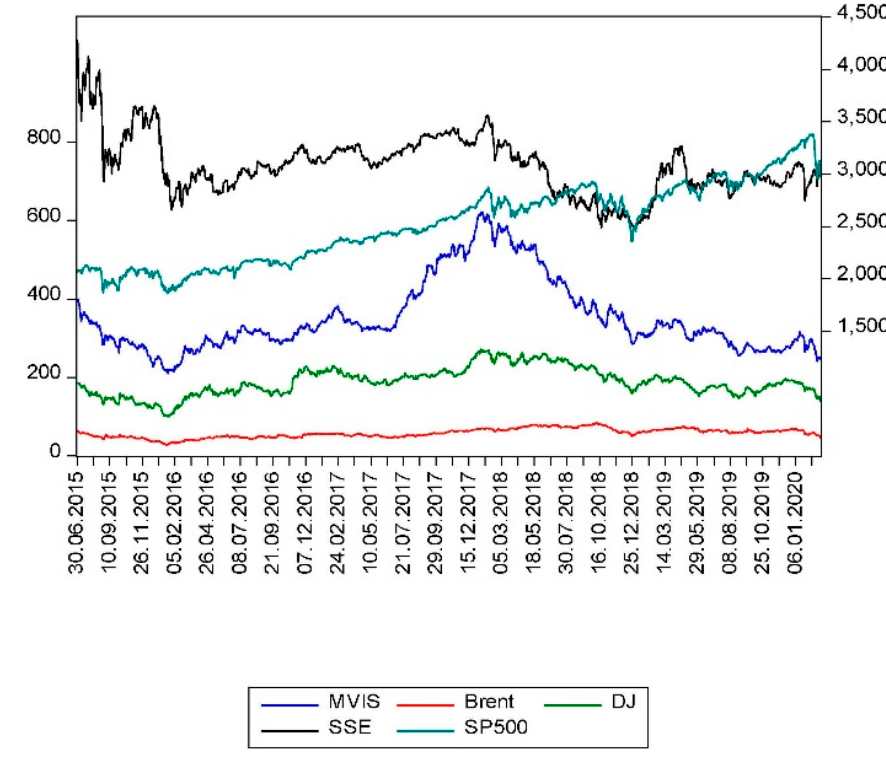
Figure 1. Price trend of rare earth, oil, industrial metals, Chinese and US stock markets.